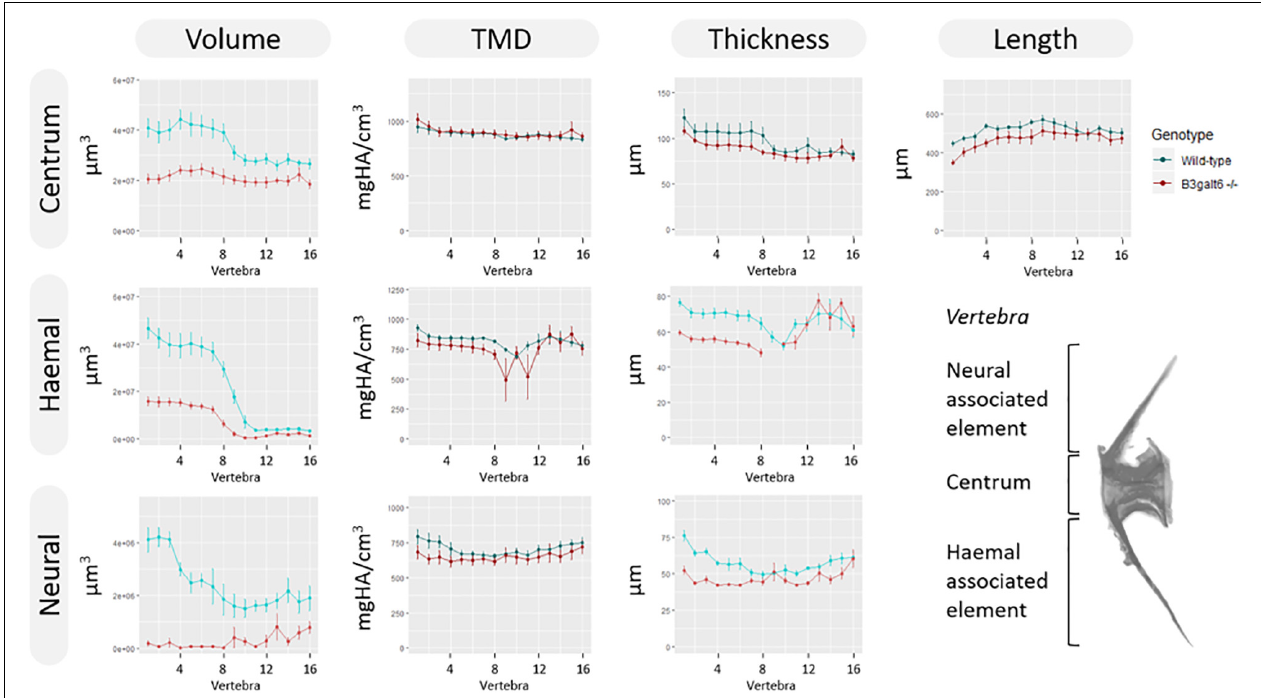
FIGURE 6 | µ CT analysis of adult WT and b3galt6 − / − zebrafish. Quantitative µ CT analysis of the vertebral column in five mutants vs. five WT zebrafish at the age of 4 months. The bone volume, tissue mineral density (TMD) and bone thickness were calculated for three parts of each vertebra: the vertebral centrum, the neural associated element (neural arch and neural spine) and the haemal associated element (haemal arch and haemal spine). Plots associated with a significant difference are colored in a lighter coloring scheme. The X -axis represents each vertebra along the anterior-posterior axis. The volume is significantly reduced for each part of the vertebra in b3galt6 − / − zebrafish ( P < 0.01, P < 0.001, and P < 0.000001, respectively). The thickness of the haemal ( P < 0.01) and neural ( P = 0.001) associated element is also significantly reduced in the mutants whereas the centrum thickness is not significantly reduced in b3galt6 − / − zebrafish ( P = 0.12). TMD is not significantly different between b3galt6 − / − zebrafish and WT siblings when not normalized for standard length ( P > 0.2). Data are presented as mean ± SEM. TMD, tissue mineral density; HA,